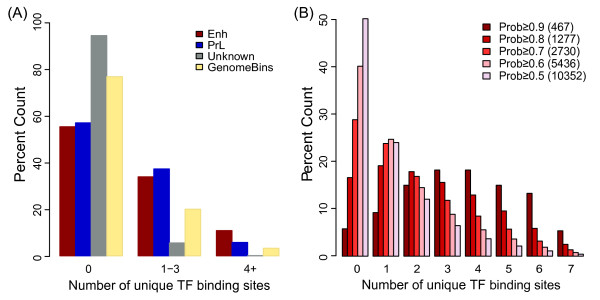
Enhancer candidates overlap multiple transcription factor bound loci.(A) Percentage overlap of Enh, PrL, Unknown and all 1 kb genome bins to TF bound regions in three categories (0, 1–3 or 4+ TFs). Generated by comparison to ChIP-Seq data for 7 ES cell-expressed TFs (excluding OCT4, SOX2, NANOG, MYC and MYCN). The Enh candidates are significantly enriched with MTL in comparison to the PrL and unknown sets as well as whole genome bins with p-values <0.001. (B) Percentage overlap of Enh candidates with TF bound regions using various enhancer probability thresholds. The numbers in brackets beside enhancer probability thresholds show the number of regions predicted to be Enh using the indicated threshold.